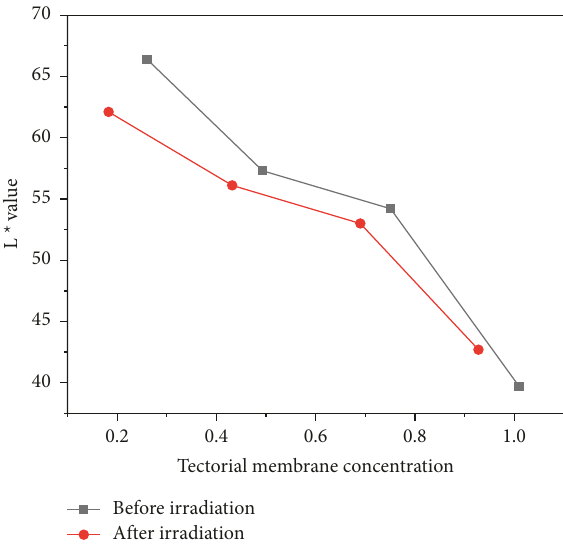
Figure 2: L ∗ value before and after the aging of nano-TiO with silicon aluminum at different concentrations.